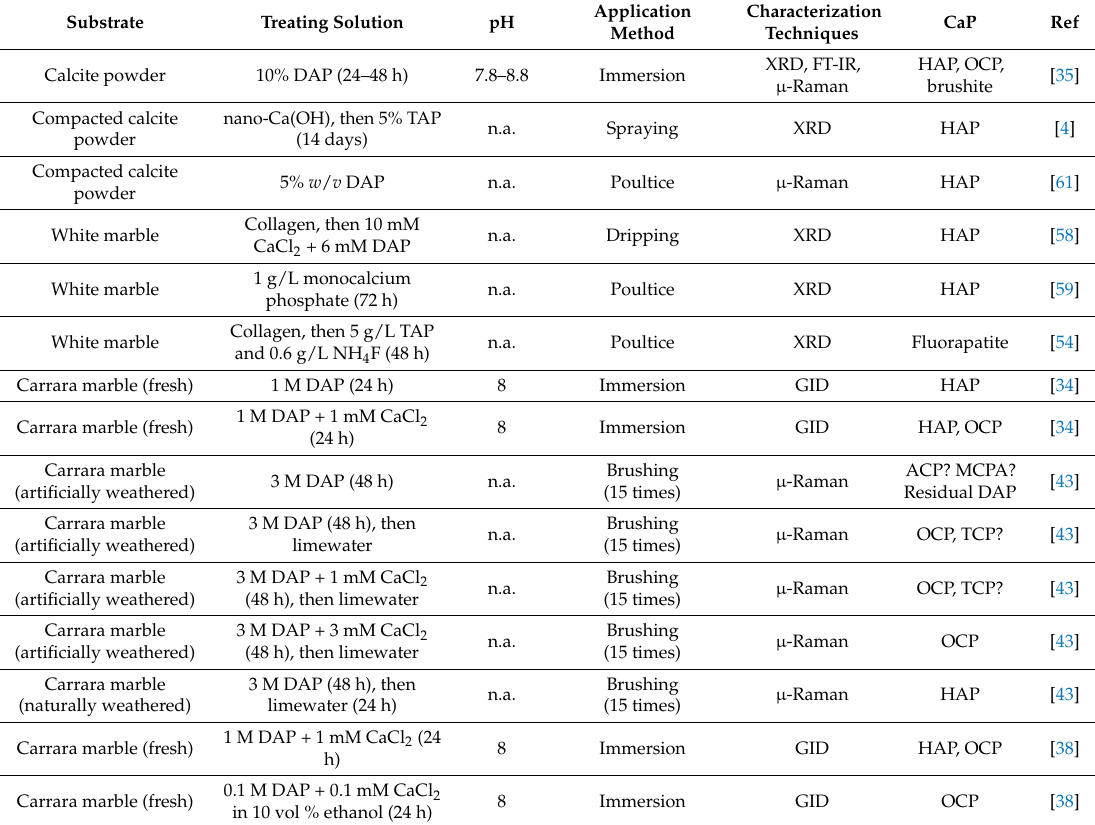
Table 3. Mineralogical composition of the CaP phases formed on calcitic powders, marble and